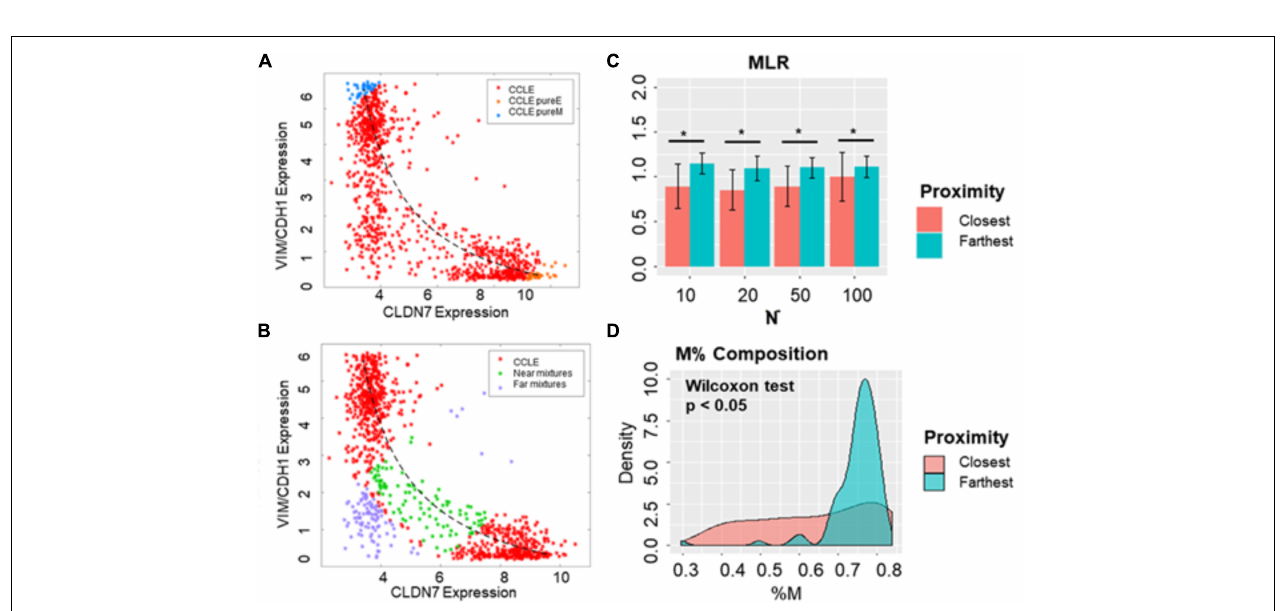
FIGURE 7 | Distinguishing between hybrid E/M cells vs. mixtures of E and M cells. (A) Scatter plot showing CCLE cell lines that display a hybrid E/M phenotype (red) on the mixture curve (dotted curve) determined by the mean of 35 pure E (orange) and pure M (blue) reference samples in CCLE dataset. (B) Scatter plot showing the 100 farthest (purple) and 100 closest (green) samples based on the distance from the mixture curve. (C) Bar plots showing EMT scores of N (10, 20, 50, and 100) closest and farthest hybrid E/M samples from mixture curve. (D) Mesenchymal proportion (%M) distribution of the 100 closest and farthest hybrid samples from mixture curve. * p < 0.05, N = 10, 20, 50 and 100, two-tailed Student’s t -test; error bars represent standard